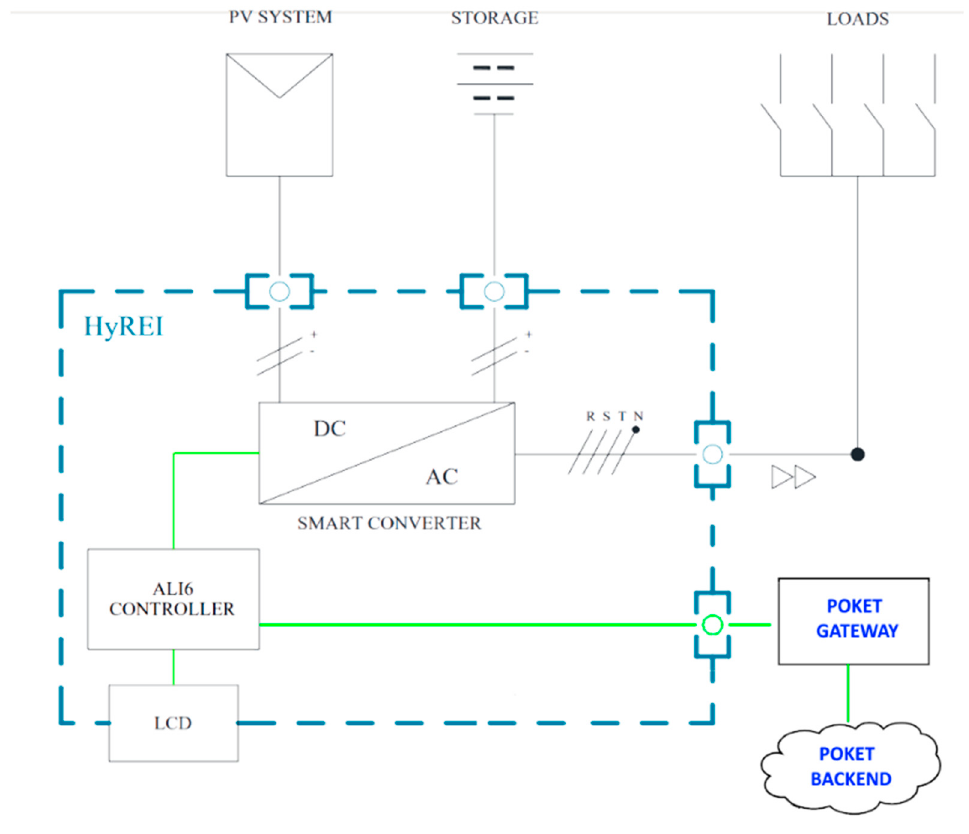
Figure 3. HiREI scheme and connection with Poket platform.